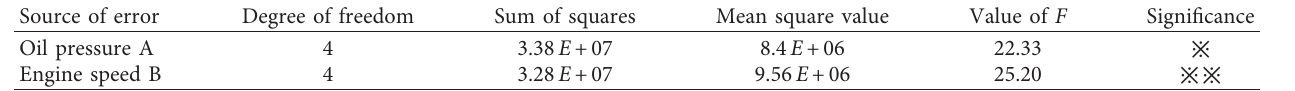
Table 5: ANOVA with all-factor test for sliding